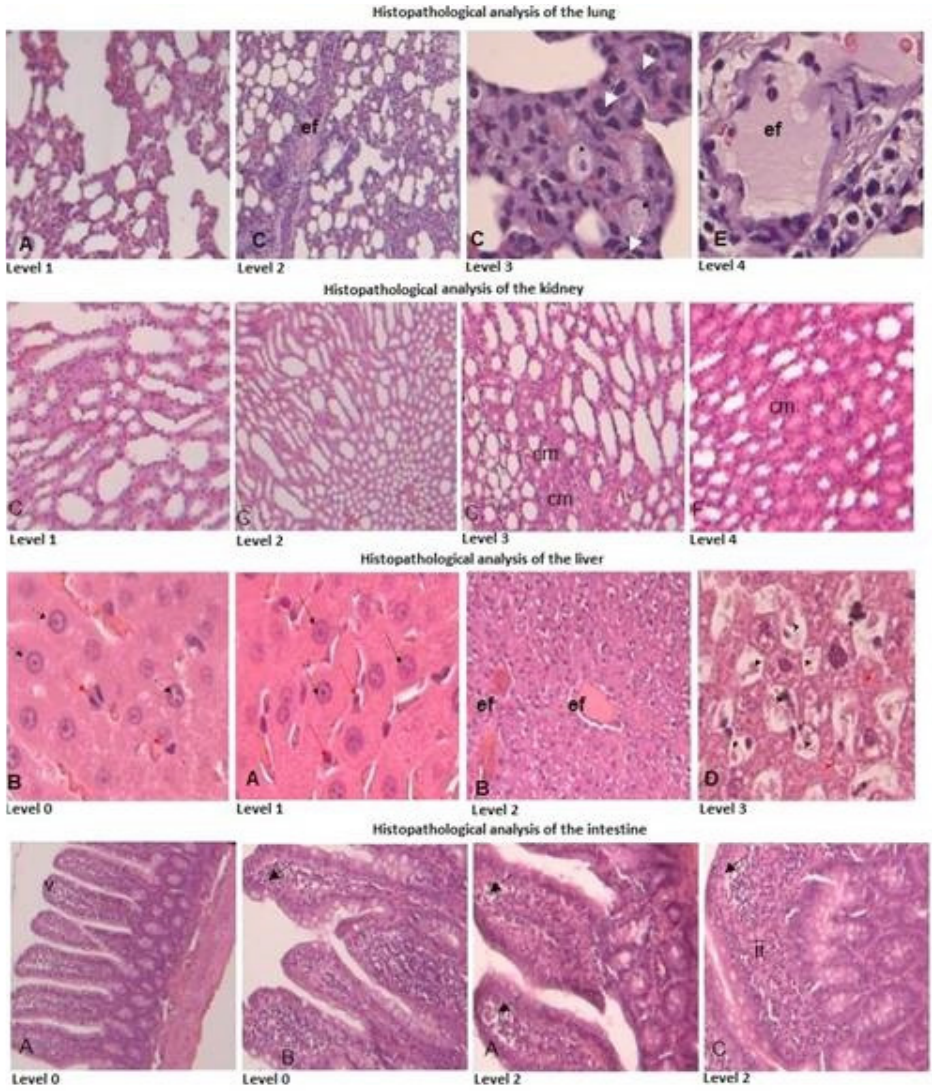
Fig. 3 – Histopathological analysis of lung, kidney, liver and